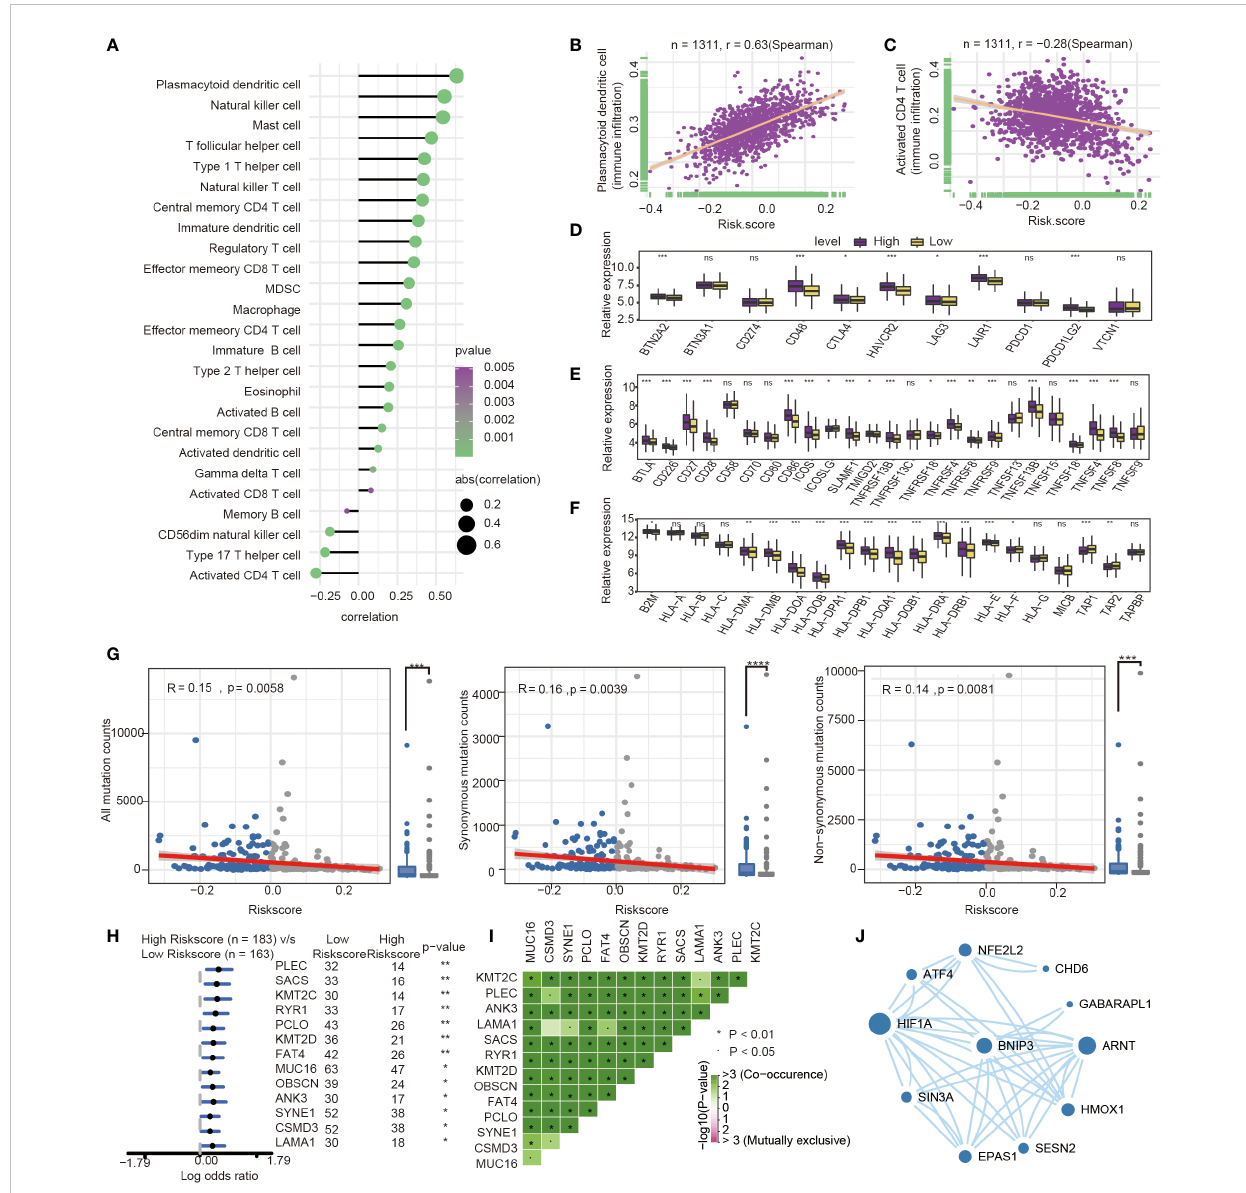
FIGURE 7 Immune-related characteristics analysis between high-risk group and low-risk group. (A) Correlation between immune in fi ltration pattern and risk score. (B) Plasmacytoid dendritic cell expression positively correlated with risk score in GC patients. (C) Activated CD4 T cell expression negatively correlated with risk score in GC patients. (D – F) The differential expression of immune checkpoint molecules between high-and low-risk groups. (*, P< 0.05; **, P< 0.01; ***, P< 0.001; NS or ns, P > 0.05) (G) Association with all mutation counts, non-synonymous mutation counts, synonymous mutation counts in different risk groups. (H) Forest plot of genes mutation in GC patients of the low- and the high-risk groups. (I) Interaction effect of genes mutating differentially between low- and high-risk groups. (J) PPI network for protein of differentially expressed pathways and differential expression genes, the size of circle means the degree of each